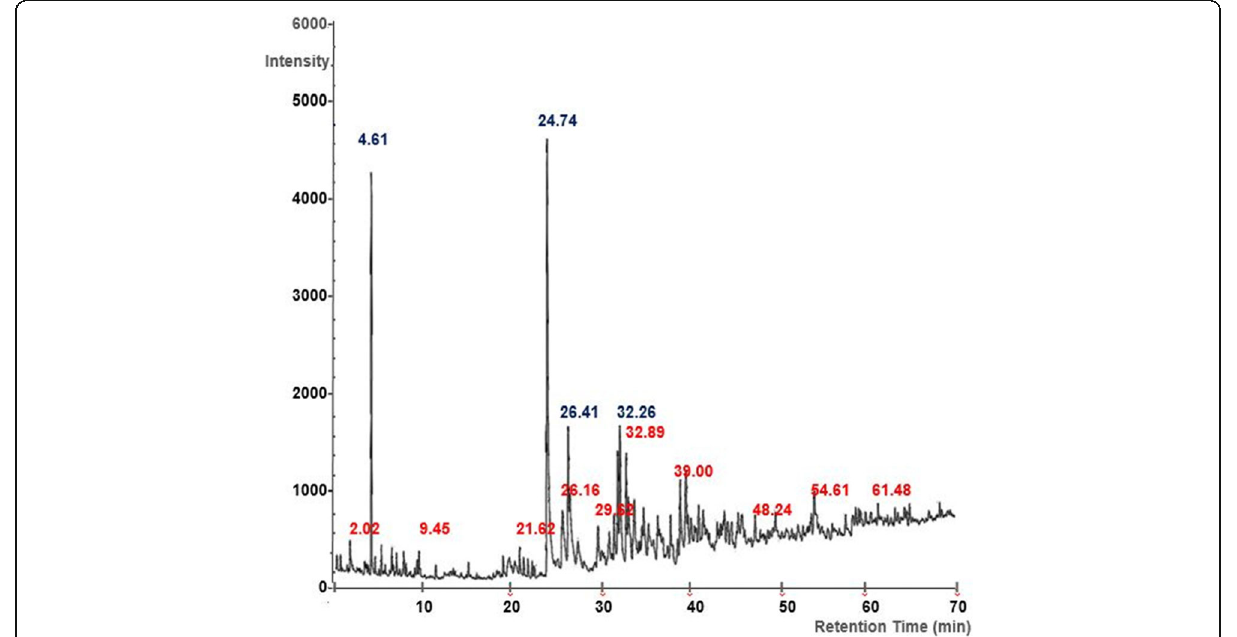
Fig. 2 A chromatogram showing the volatile organic compound present in the leaf of P .